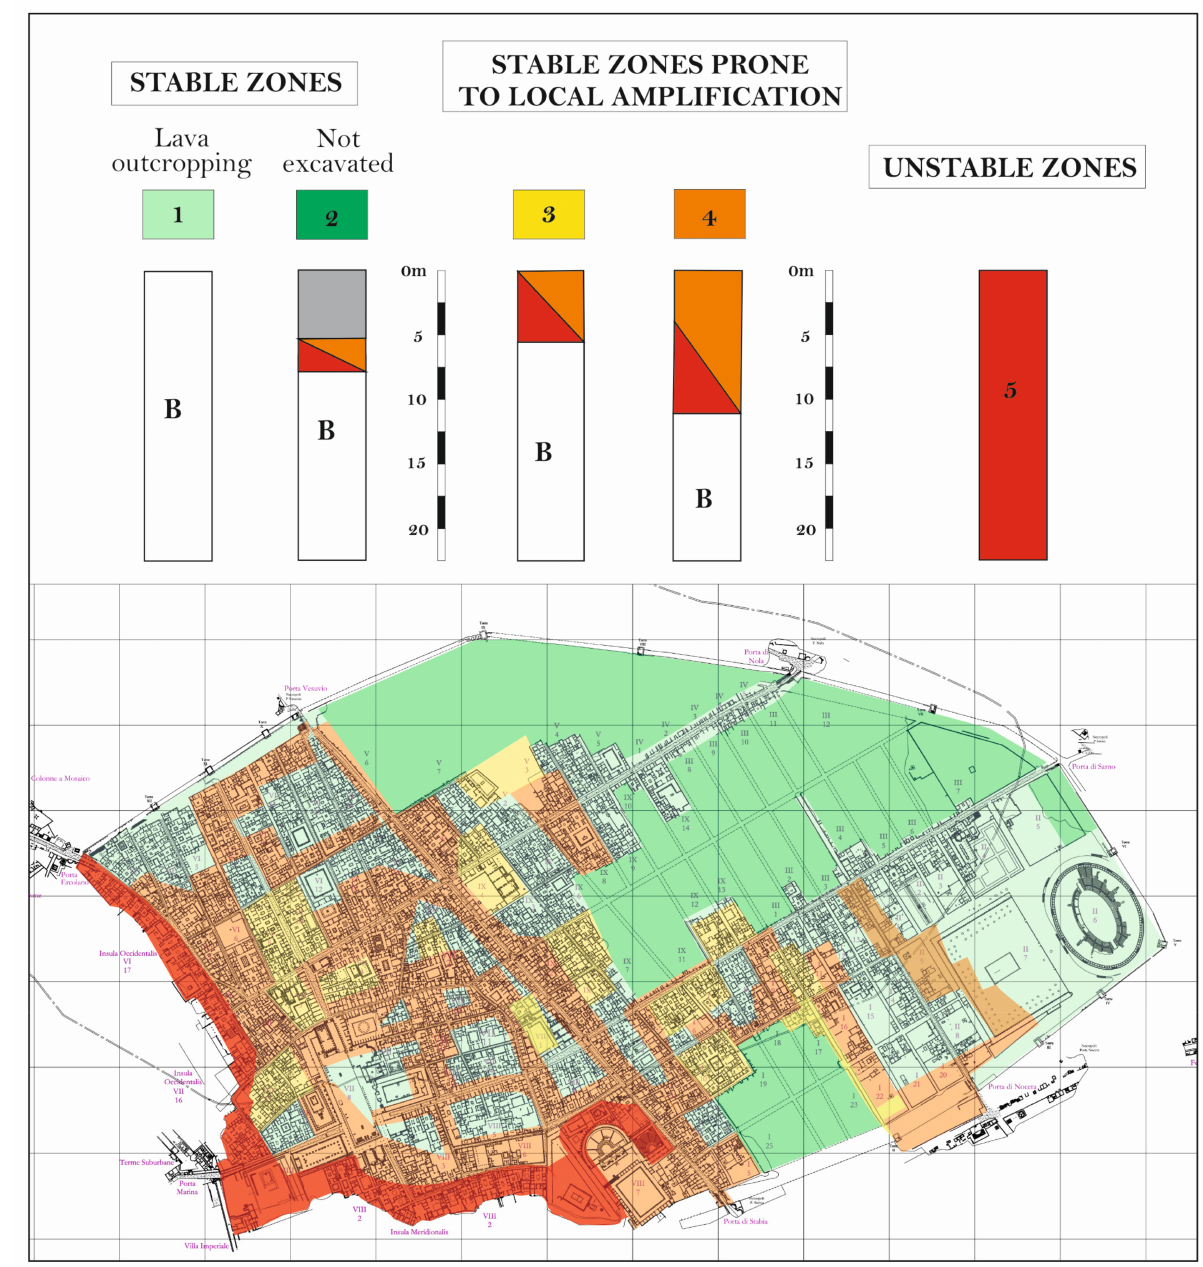
Figure 12. Seismic homogeneous microzones and seismic microzonation map of the Pompeii Archae- ological